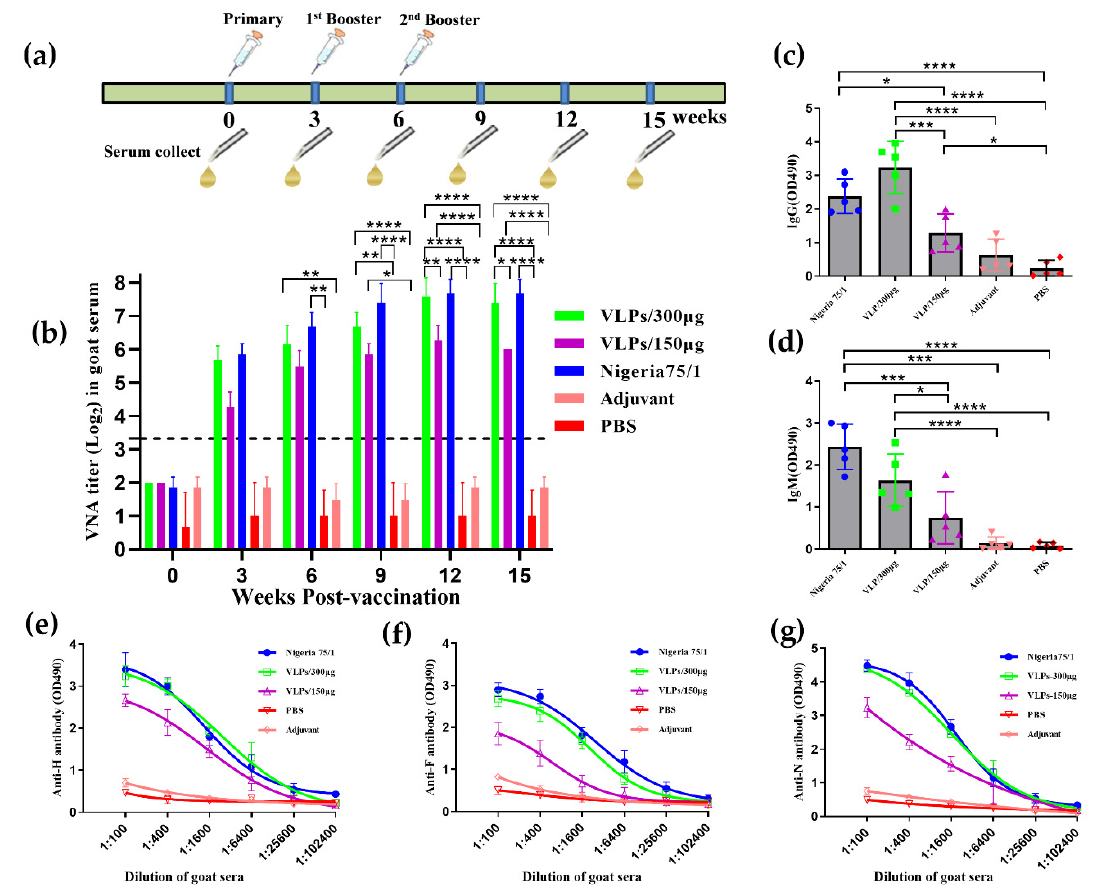
Figure 6. Immunization induces a humoral response in goats. ( a ) Goats were boosted twice every three weeks via the subcutaneous route with VLPs (150 µ g or 300 µ g), PPRV Nigeria 75 / 1, PBS, or alum adjuvant after initial immunization. ( b ) Serum samples were collected 3, 6, 9, 12 and 15 weeks after the first vaccination and virus-neutralizing antibody (VNA) titers were measured by fluorescent antibody viral neutralization (FAVN). Dotted lines represent antibody titers greater than ten, indicating positive serum conversion. ( c–d ) Total serum IgG (c) and IgM (d) responses were determined at 3 weeks. ( e–g ) Serum was collected from each goat three weeks after the third immunization for analysis by a PPRV F-, H-, and N-specific ELISA. Significant di ff erences were analyzed by one-way or two-way ANOVA and indicated as follows: *P < 0.05, **P < 0.01, ***P < 0.001, ****P <